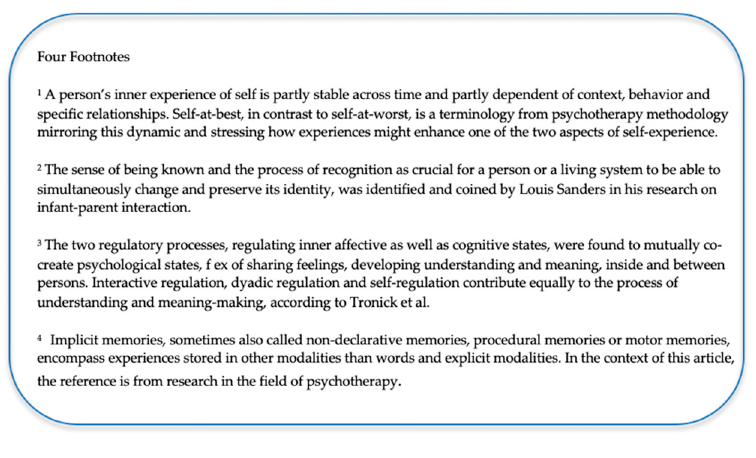
Figure 1. Four Figure 1. Four footnotes.